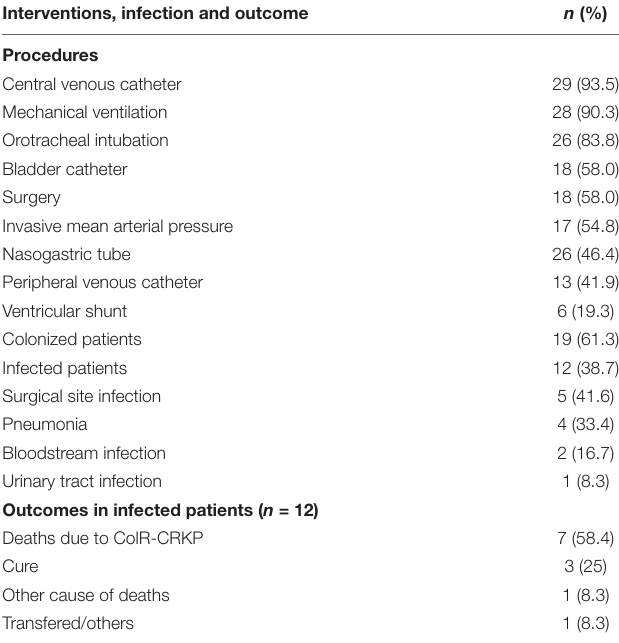
TABLE 2 | Risk factors and clinical outcome of patients infected and/or colonized by ColR-CRKP at a large tertiary hospital in Brazil ( n = 31). Interventions, infection and outcome n (%)